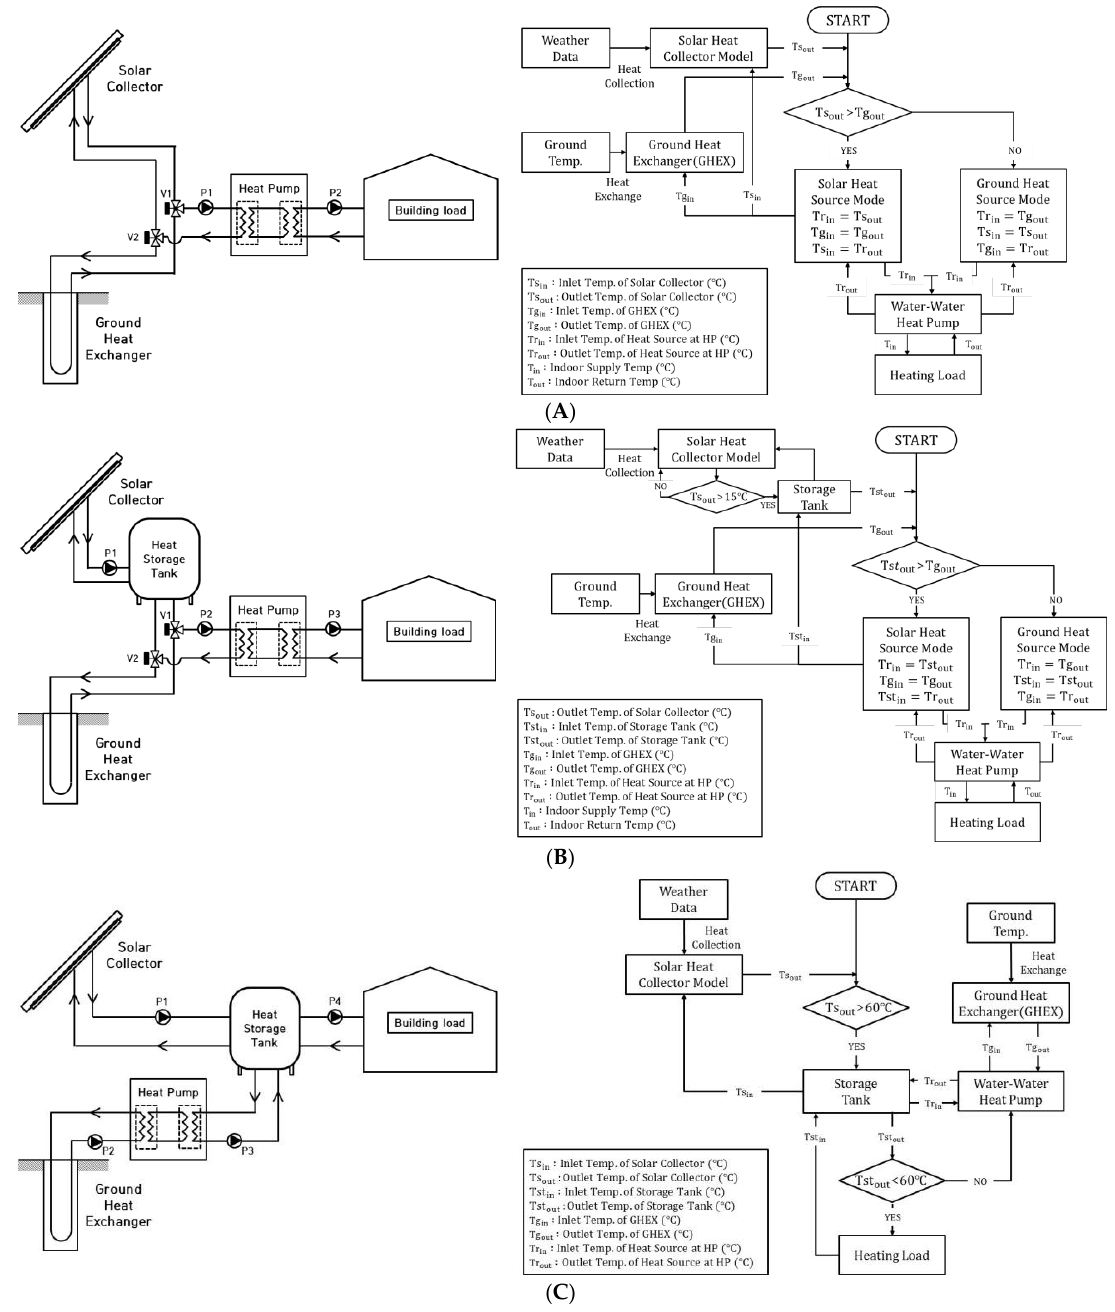
Figure 2. Conceptual diagram of systems [15]. ( A ) SYSTEM 1 [14]; ( B ) SYSTEM 2; ( C ) SYSTEM 3.